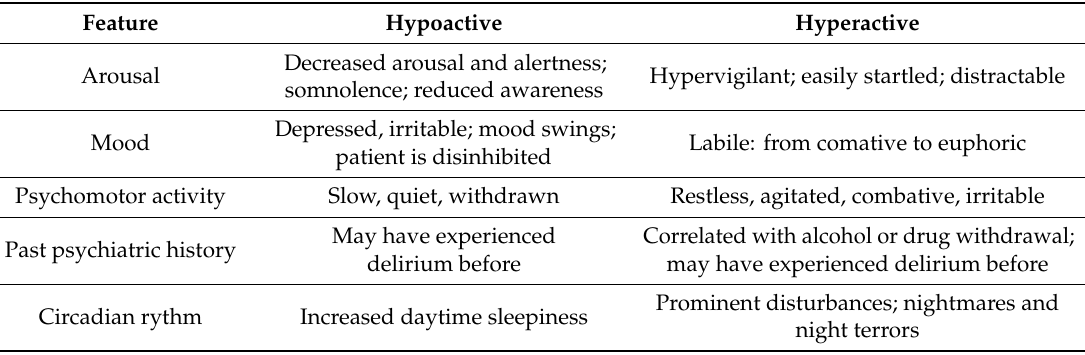
Table 3. Comparison of hypo- and hyperactive delirium